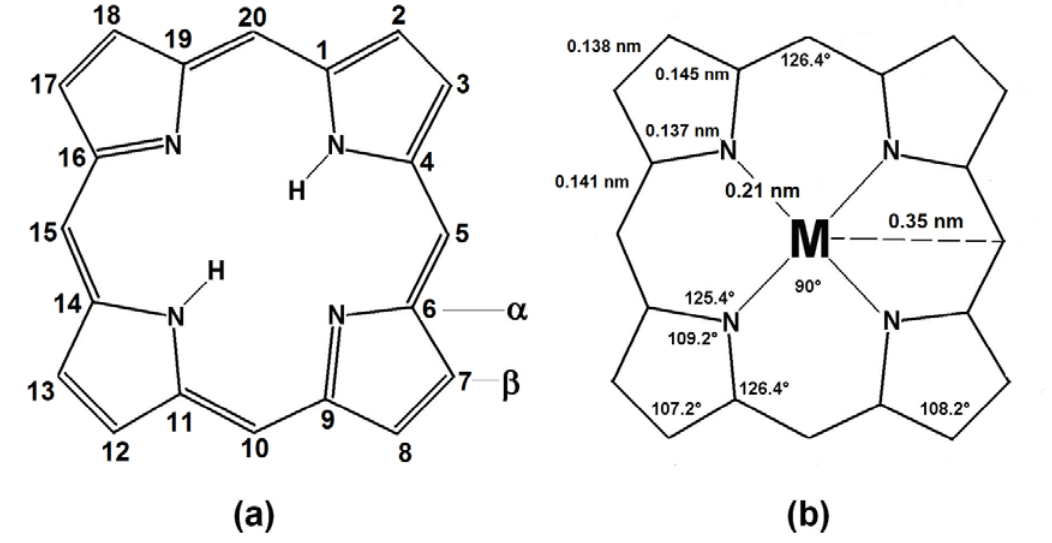
Figure 4. Structures of: ( a ) the tetrapyrrolic macrocycle of porphin and, ( b ) porphyrin, including the principal dimensional parameters and the positions of the possible